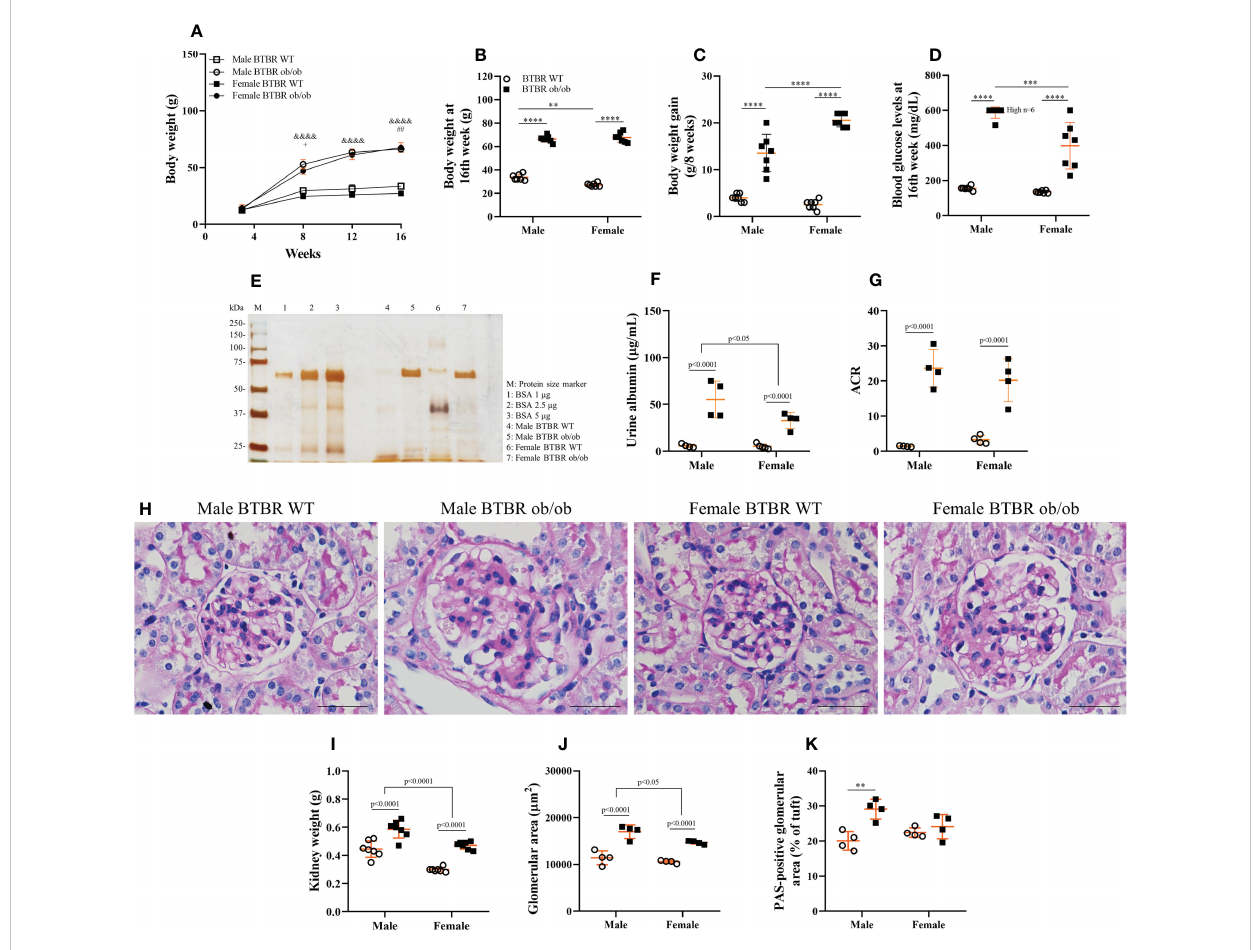
FIGURE 1 The development of obesity and diabetes and their effect on kidney function and morphology is different between males and females. Effects of sex and metabolic condition in BTBR mice on body weight/week (A) , body weight at 16 th week (B) , body weight gain (C) , blood glucose levels at 16 th week (D) , urine albumin (E, F) , albumin to creatinine ratio (G) , kidney weight (H) , glomerular area (I) , PAS-positive glomerular area (J) , and glomerular morphology (K) . p values corresponding to the independent effect of metabolic condition or sex are speci fi ed in the graphs. p values of two-way ANOVA followed by Tukey ’ s multiple comparisons test are as follows: &&&& p<0.0001 versus the respective WT controls; + p<0.05 versus male BTBR ob/ob; ## p<0.01 versus male BTBR WT. The values are the mean±SD (n=4 - 7). (E) : Representative full-length silver-stained gel of urine samples. (K) : Kidney slices were stained with Periodic acid – Schiff for morphological analysis and images were captured using NIS-Elements software coupled to a light microscope equipped with a 40x objective. Bars = 50 m m. WT, wild type; kDa, protein size; BSA, bovine serum albumin; ACR, albumin to creatinine ratio. **p< 0.01; ***p< 0.001,